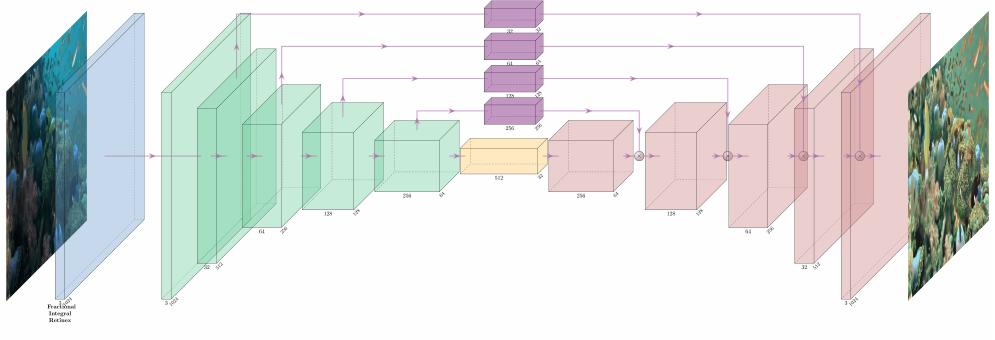
Figure 7. The structure of the proposed end-to-end underwater-image-enhancement